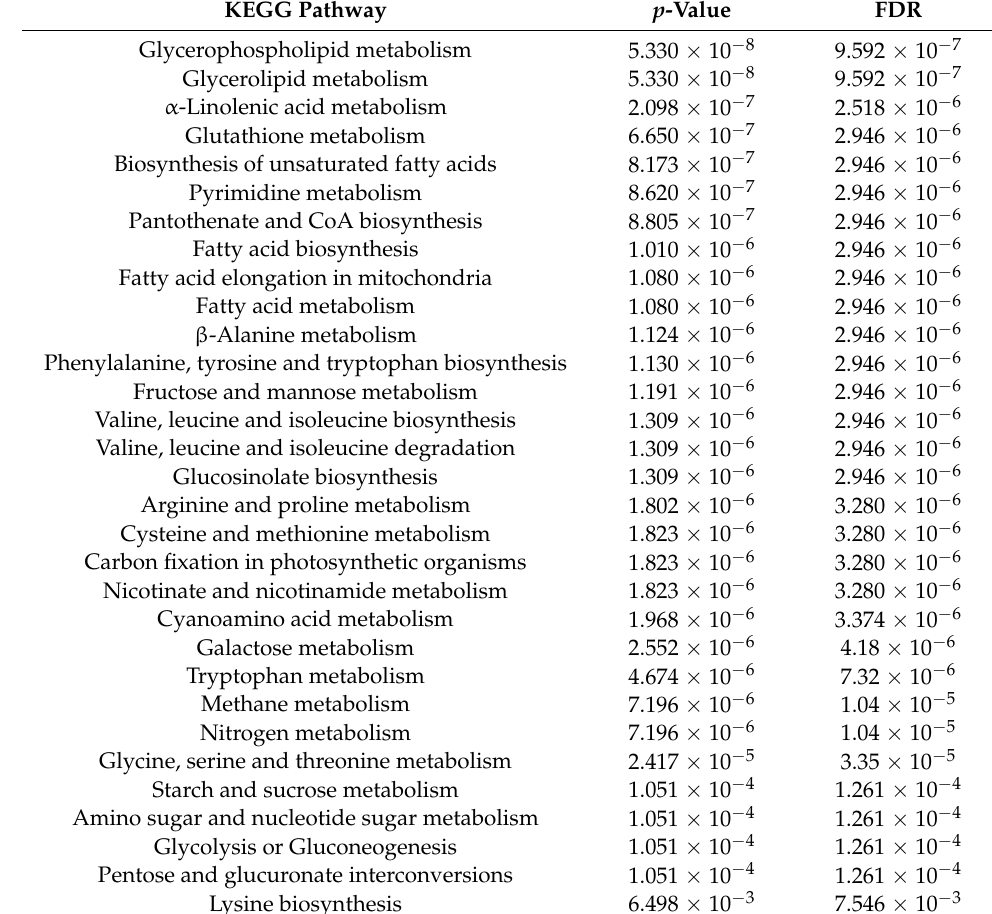
Table 3. Significantly enriched KEGG pathways associated with differential